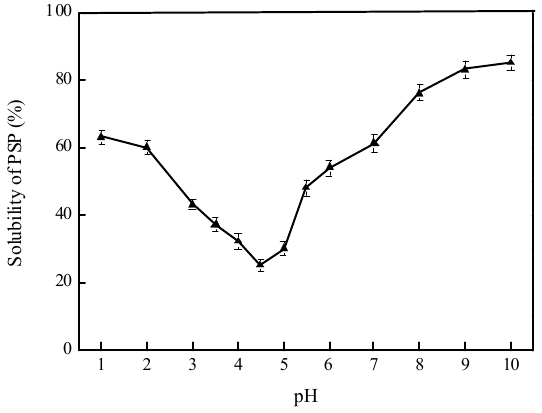
Figure 1. pH-solubility curve of Perilla seed protein (PSP). Values are means ± SDs (n = 3).